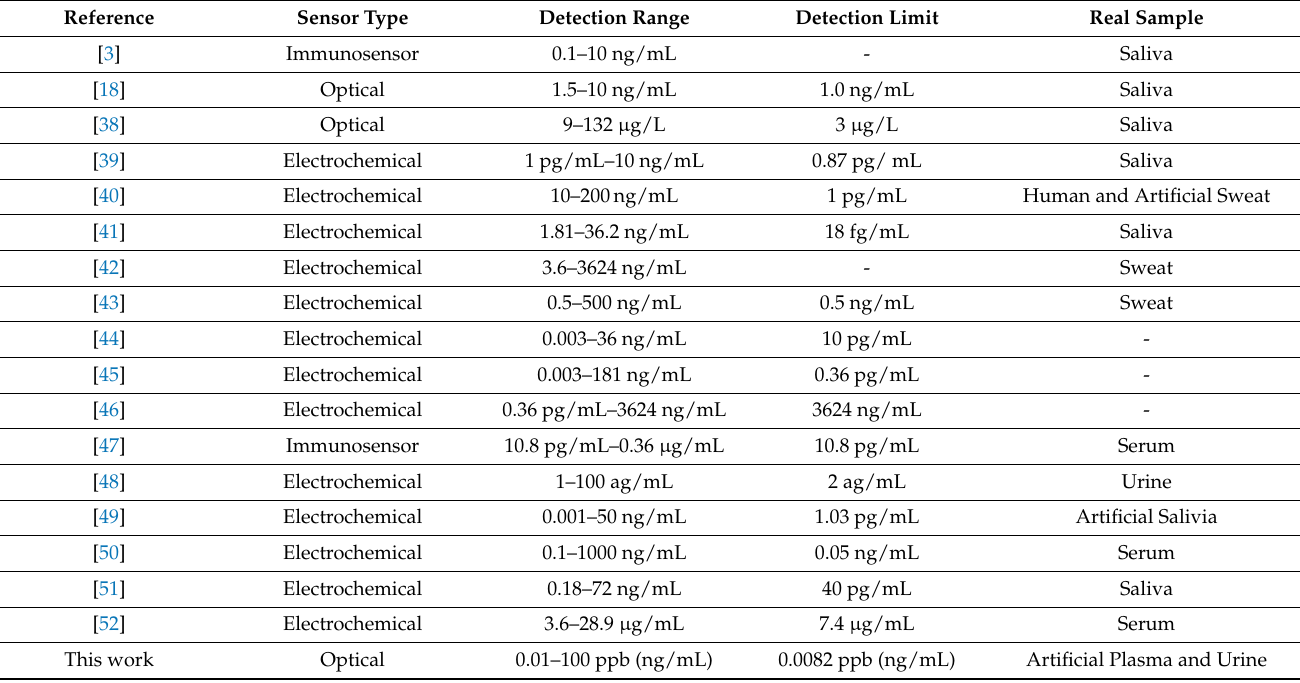
Table 2. Comparison of studies for cortisol